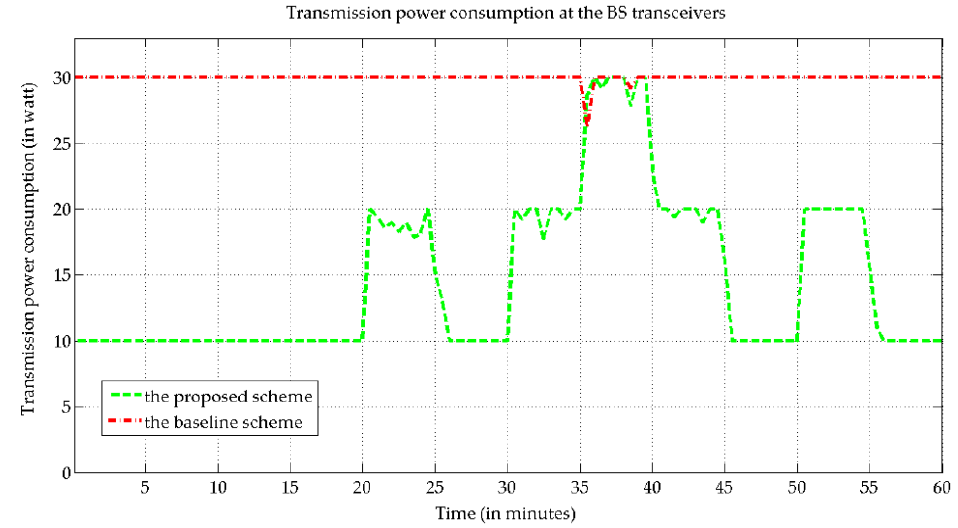
Figure 7. A comparison of the levels of transmission power consumption for the proposed scheme and the conventional scheme.